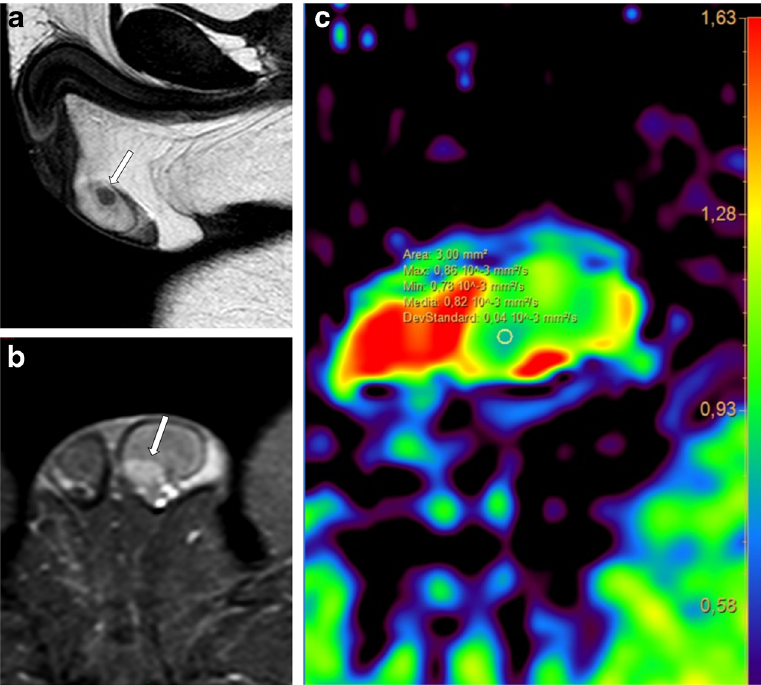
Fig. 5 a - c MR study in a case of benign Leydig cells tumour. a T2- weighted TSE sequence, sagittal view and b post-contrast T1- weighted SPIR TSE sequence, axial view, depicting a round hypointense on T2-wi testicular focal lesion (arrow), with homogeneous hyperenhancement. c ADC map